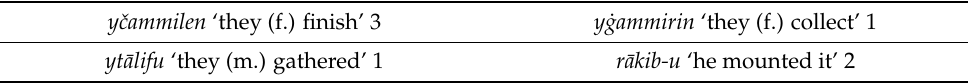
Table 1. Trochaic occurrences in